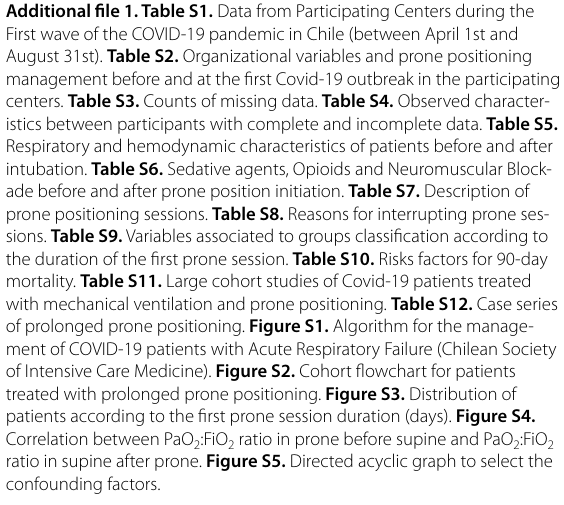
Additional file 1. Table S1. Data from Participating Centers during the First wave of the COVID‑19 pandemic in Chile (between April 1st and August 31st). Table S2. Organizational variables and prone positioning management before and at the first Covid‑19 outbreak in the participating centers. Table S3. Counts of missing data. Table S4. Observed character‑ istics between participants with complete and incomplete data. Table S5. Respiratory and hemodynamic characteristics of patients before and after intubation. Table S6. Sedative agents, Opioids and Neuromuscular Block‑ ade before and after prone position initiation. Table S7. Description of prone positioning sessions. Table S8. Reasons for interrupting prone ses‑ sions. Table S9. Variables associated to groups classification according to the duration of the first prone session. Table S10. Risks factors for 90‑day mortality. Table S11. Large cohort studies of Covid‑19 patients treated with mechanical ventilation and prone positioning. Table S12. Case series of prolonged prone positioning. Figure S1. Algorithm for the manage‑ ment of COVID‑19 patients with Acute Respiratory Failure (Chilean Society of Intensive Care Medicine). Figure S2. Cohort flowchart for patients treated with prolonged prone positioning. Figure S3. Distribution of patients according to the first prone session duration (days). Figure S4. Correlation between PaO 2 :FiO 2 ratio in prone before supine and PaO 2 :FiO 2 ratio in supine after prone. Figure S5. Directed acyclic graph to select the confounding